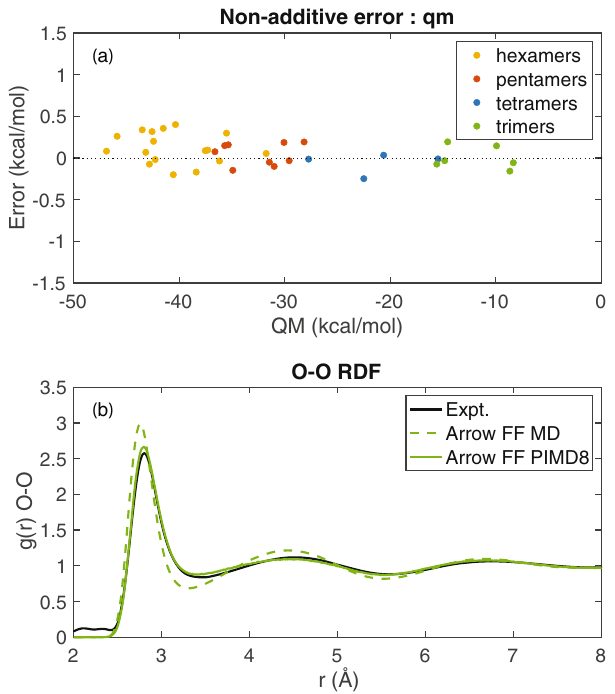
Fig. 2 Properties of the ARROW water model. a The non-additive many- body error for water multimers vs. their total QM intermolecular energy. All the many-body errors are below 0.5 kcal/mol or 1% of total energy, and below 3% of the many-body contributions. b The radial distribution function for the O – O distance in water. The MD RDF (dotted green) is over- structured compared with the experimental curve, and the presence of NQE (solid green) brings the structure of ARROW H 2 O in excellent agreement with the experimental